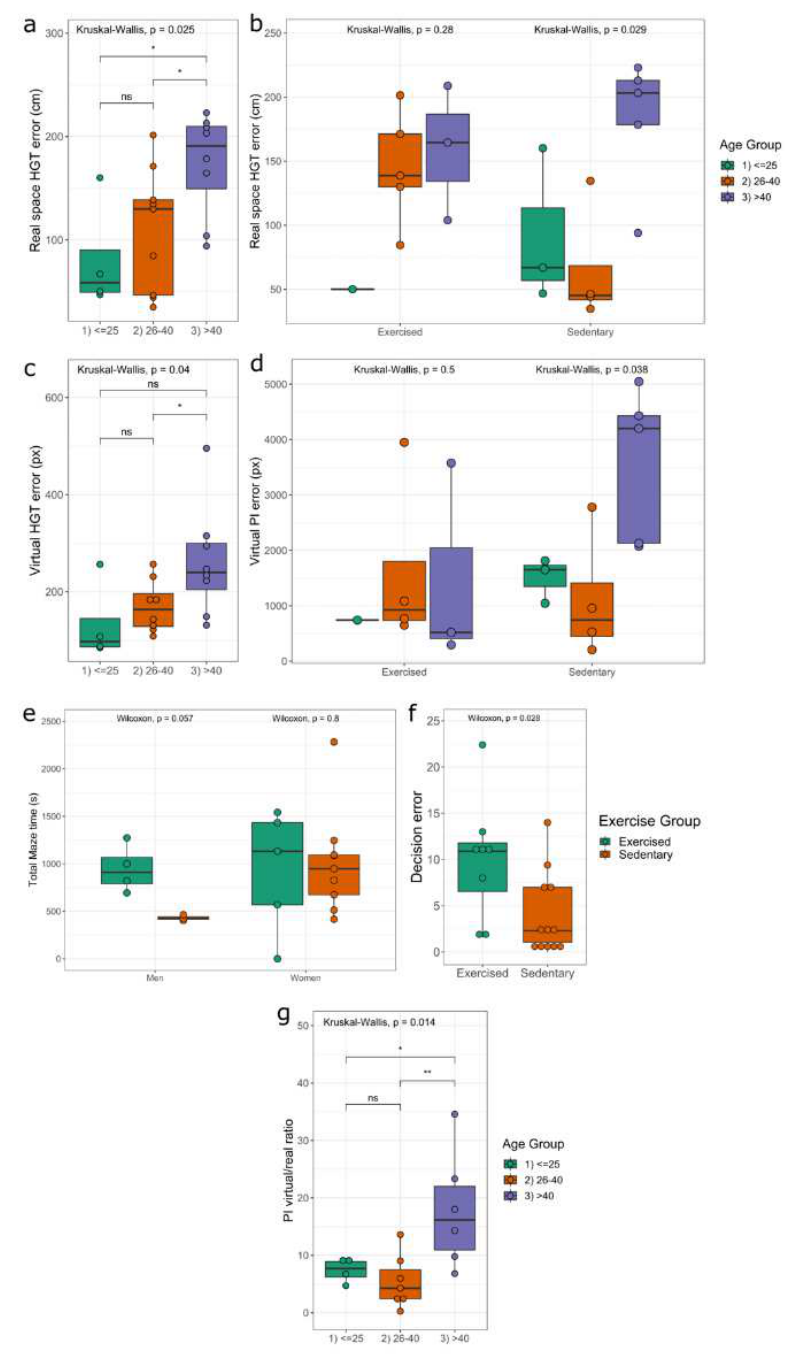
Figure 6. Complex interactions between variables. The relationship between some of the significant results found here depending on several variables was analyzed. Significant differences found between groups ( a , c , f , g ) and between subgroups ( b , d , e ) within our study variables. The